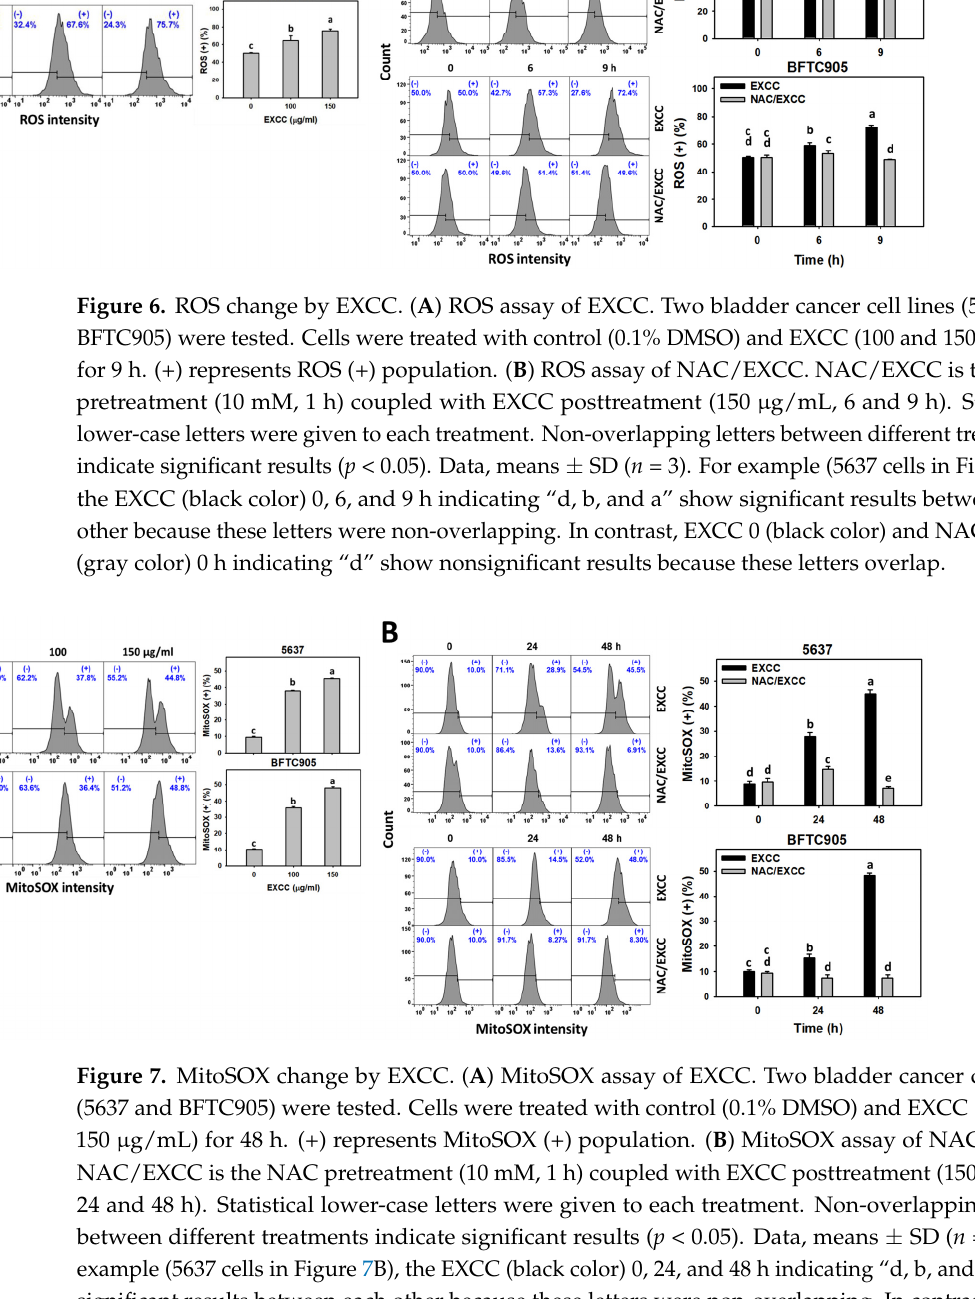
similar to the control (Figure